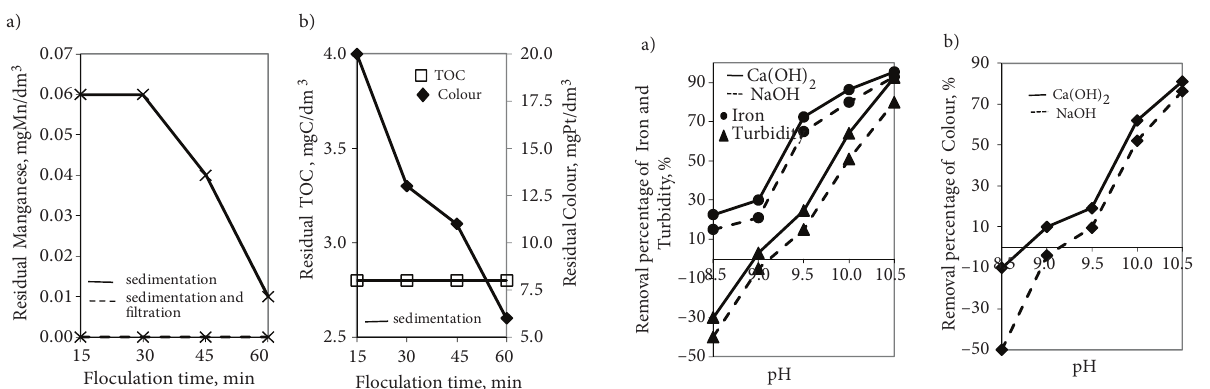
Figure 6. Influence of flocculation time on residual manganese (a) and residual TOC and residual colour (b) in the water after the Ca(OH) 2 alkalinisation to pH = 10